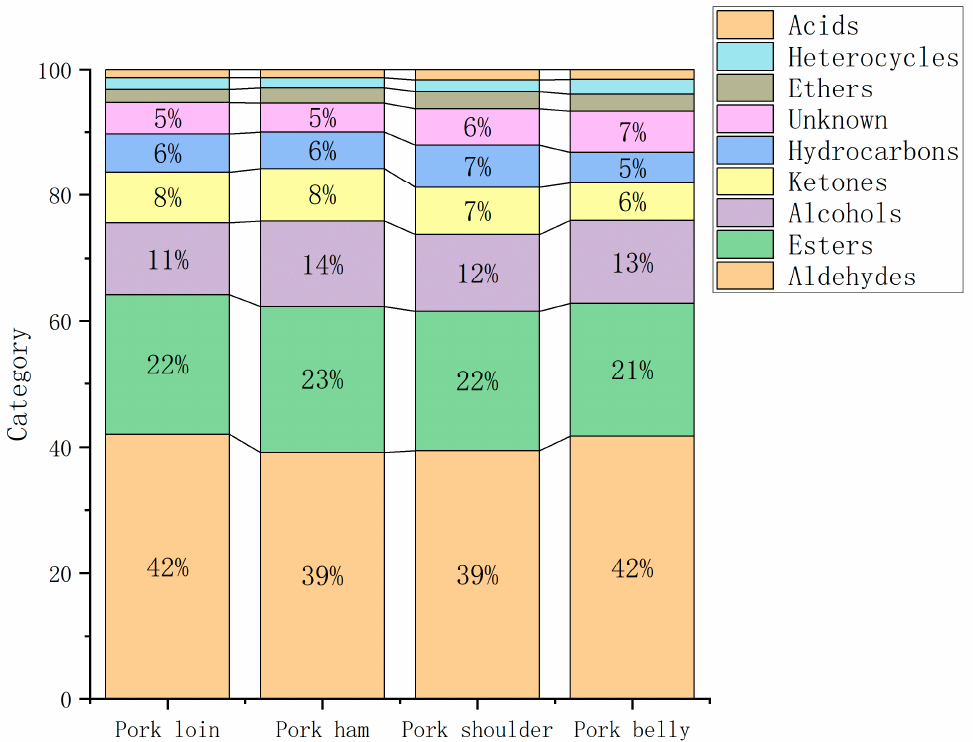
Molecules 2023 , 28 , x FOR PEER REVIEW Figure 4. Proportions of volatile organic compounds in four muscles of pork. Figure 4. Proportions of volatile organic compounds in four muscles of pork.